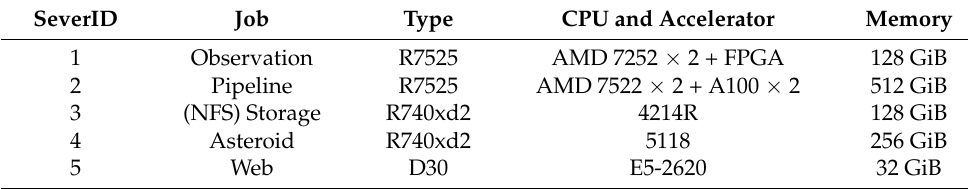
Table 1. Computer System for AST3-3 in Yaoan